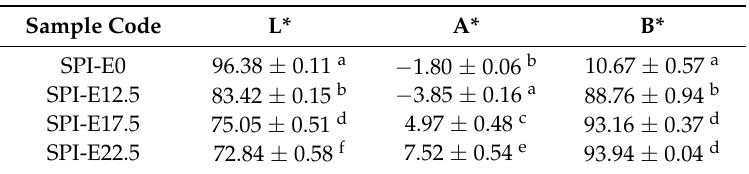
Table 3 . Color properties of the films. Table 3. Color properties of the films.